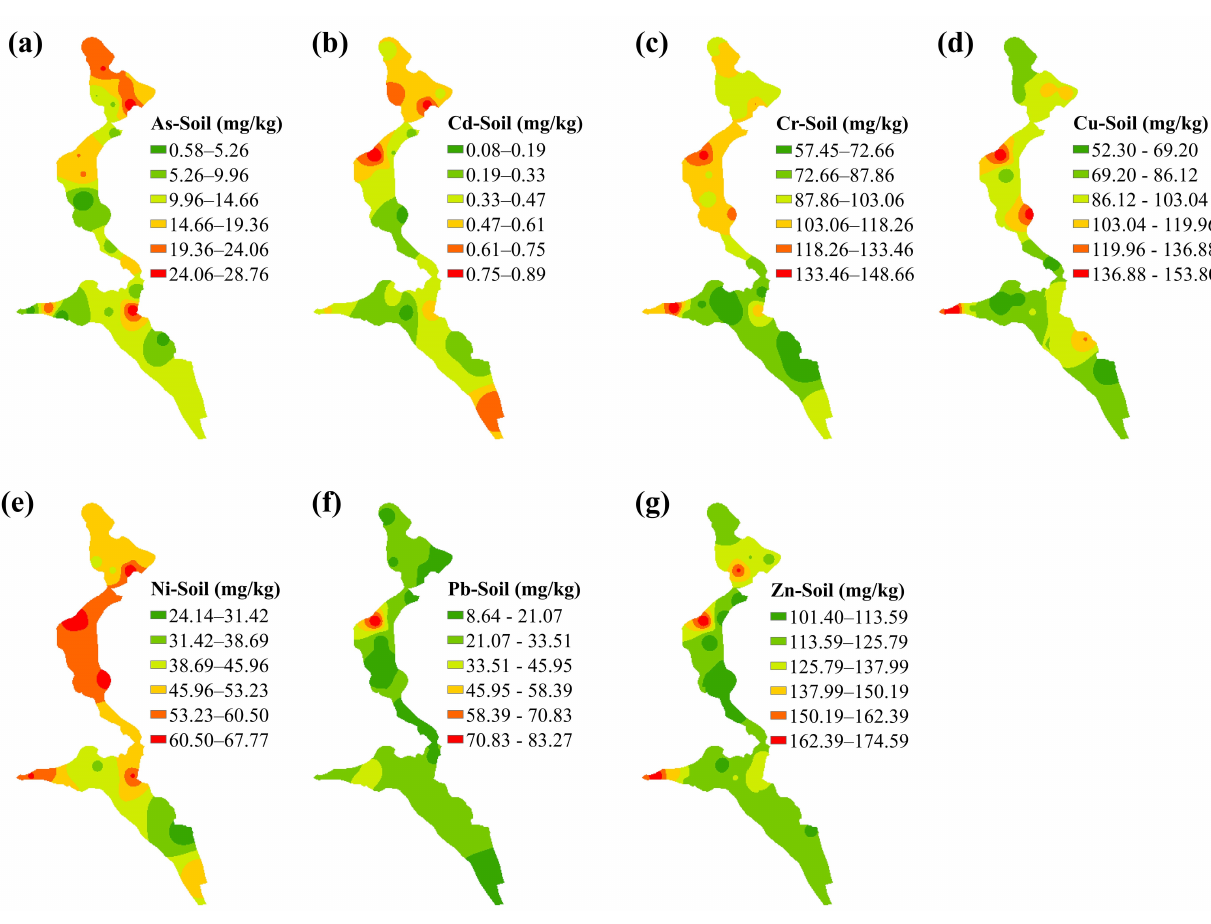
Figure 2. Spatial distribution of ( a ) As, ( b ) Cd, ( c ) Cr ( d ) Cu, ( e ) Ni, ( f ) Pb and ( g ) Zn in soils.